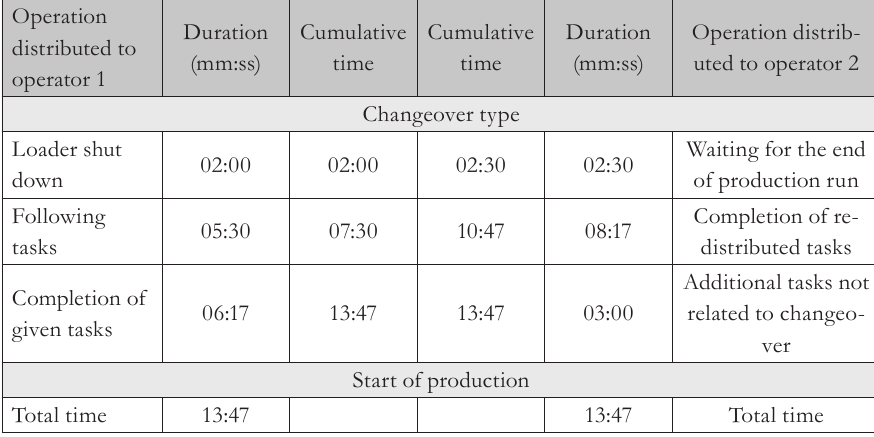
Tab. 3 – Distributing individual activities between two operators (Source: own)